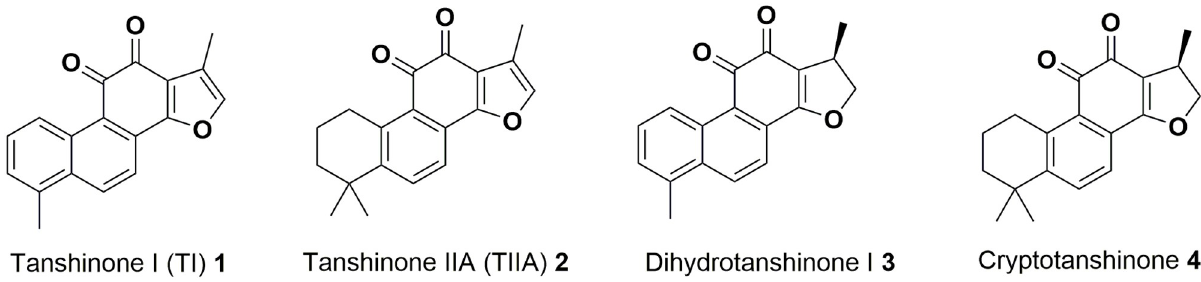
Fig 1. Structures of some naturally occurring tanshinones